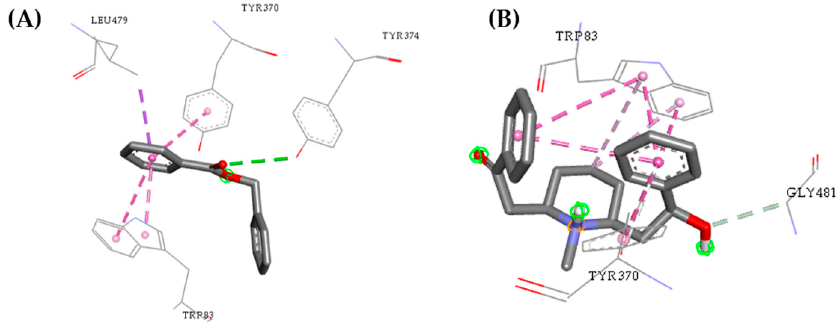
Figure 7. Interactions between the acetylcholinesterase active site and the compounds ZINC00001021 ( A ) and ZINC00001624 ( B ).